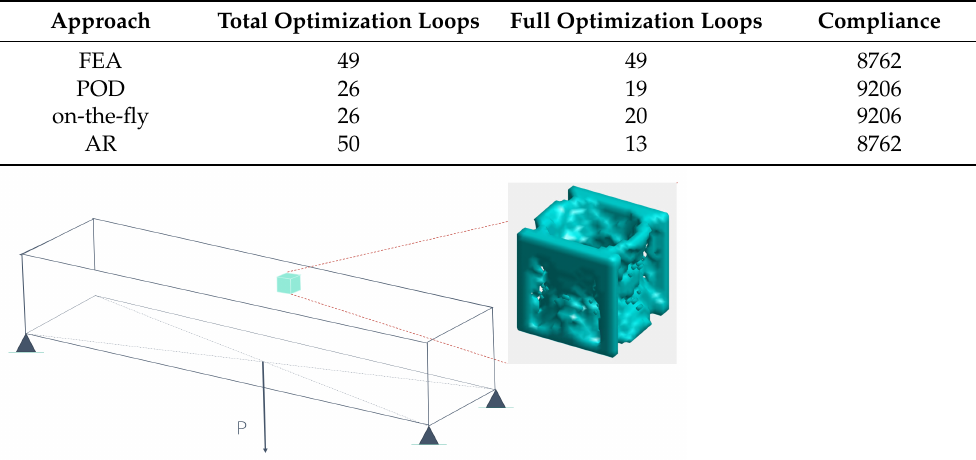
Figure 4. Optimized periodic unit cell for the cantilever beam test example of the macro